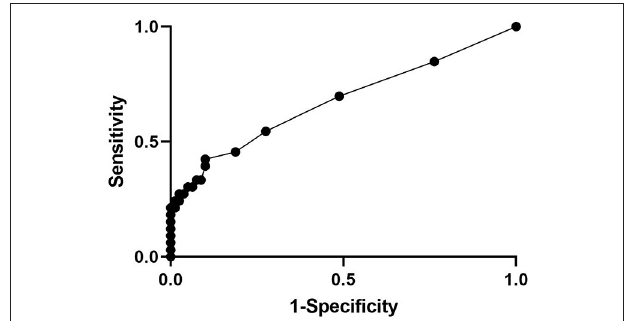
FIGURE 1 | Receiver operating characteristic curve for TNCC to predict survival.